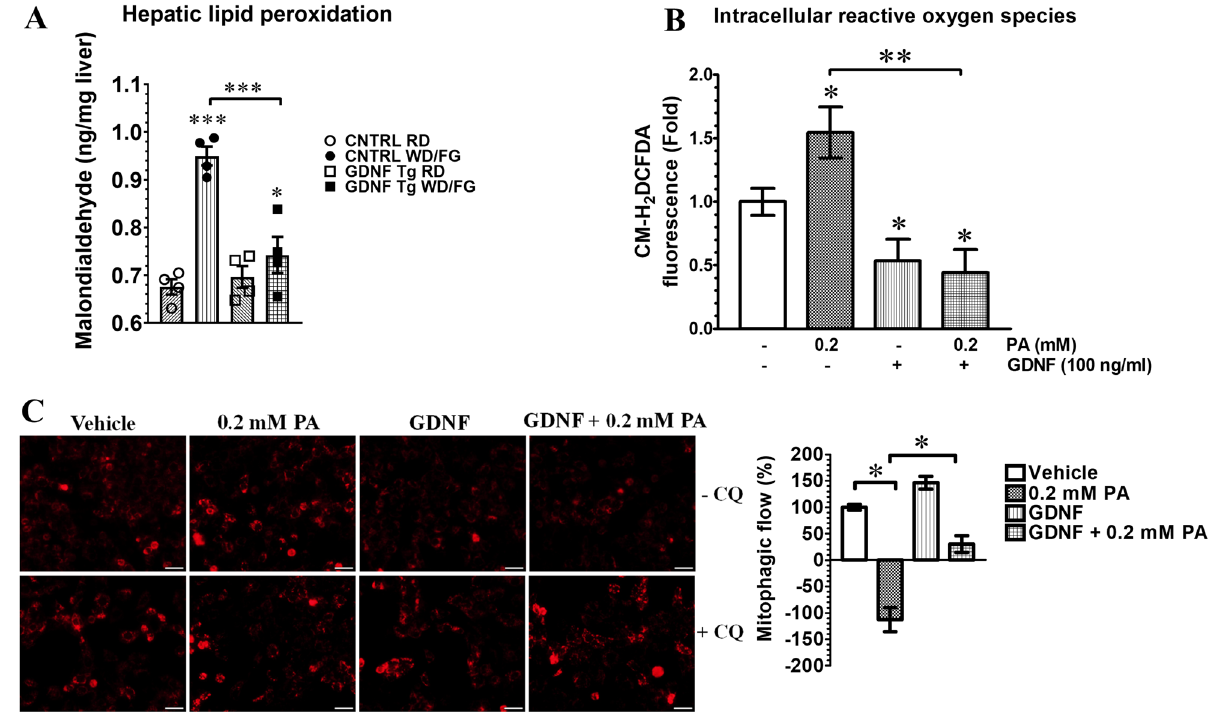
Figure 1. GDNF reverses Western diet- and palmitate-induced oxidative damage and impairment of mitophagy in hepatocytes. ( A ) Hepatic malondialdehyde (MDA) levels in control (CNTRL) and GDNF transgenic (GDNF Tg) mice fed regular diet (RD) or Western diet with fructose and glucose in drinking water (WD/FG) for 25 weeks. Plotted are means + SE. ***P < 0.001; *P < 0.05, relative to RD-fed control mice. N = 4 mice per group. ( B ) Intracellular ROS levels measured as CM-H 2 DCFDA fluorescence intensity in rat hepatocytes cultured for 24 h in the presence and absence of palmitate and GDNF. Plotted are means ± SE. **P < 0.01, *P < 0.05 relative to Vehicle-treated hepatocytes; N = 5. ( C ). Rat hepatocytes cultured for 6 h in the presence or absence of palmitate (PA), GDNF, and the lysosomal inhibitor chloroquine (CQ) and stained with MitoTracker Red CMX-ROS and plot of mitophagic flow expressed as % of Vehicle. Scale, 50 µm. Plotted are means ± SE. *P < 0.05; N = 2